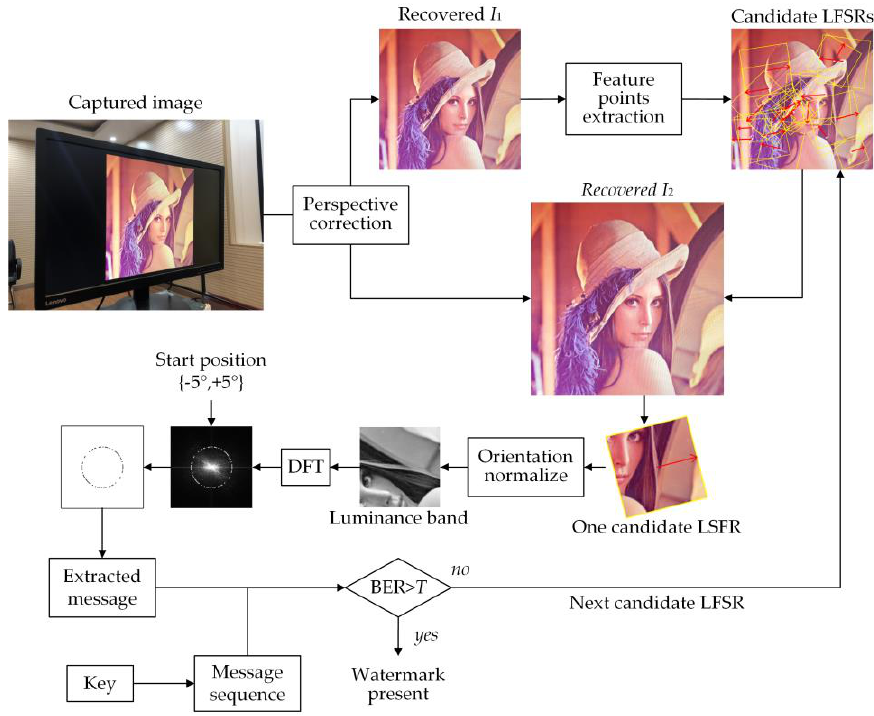
Figure 8. Framework of watermark detection process.